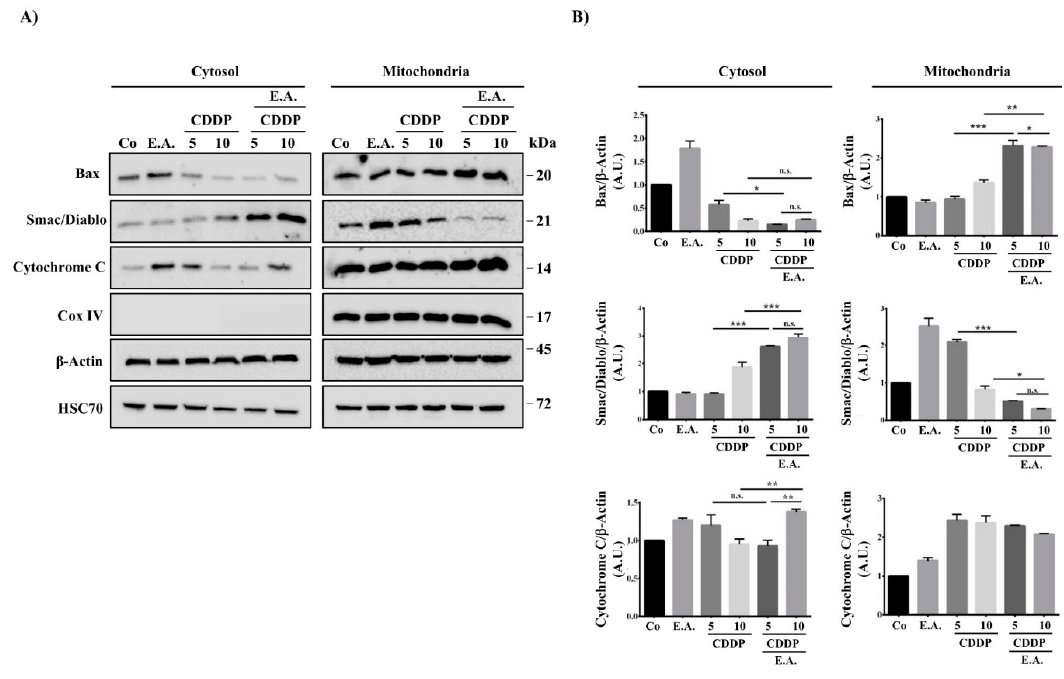
Figure 6. E.A. / CDDP combination synergized to activate intrinsic death pathway in breast cancer cells. ( A ) Immunoblotting analysis of indicated proteins in 4T1 cells exposed for 48 h to the vehicle